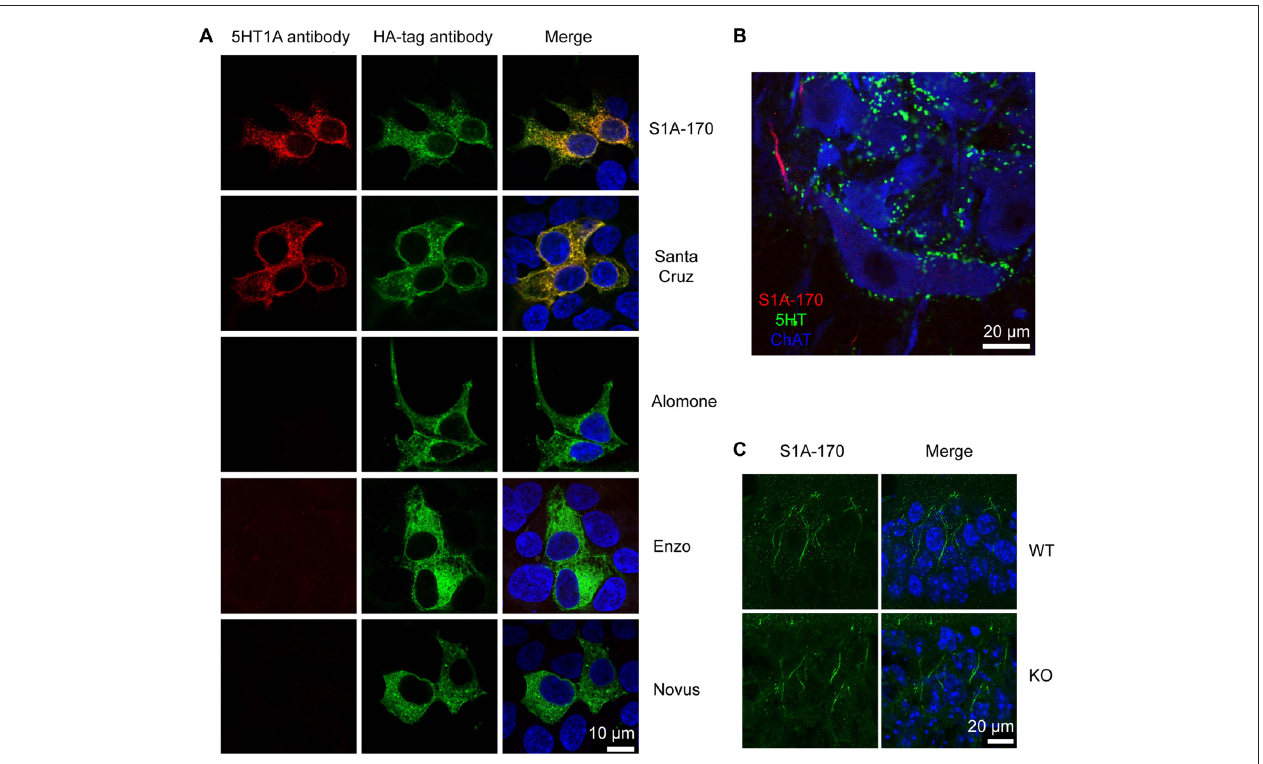
FIGURE 4 | Unspecificity of available 5HT 1A antibodies. (A) HEK293 cells transfected with HA-tagged h5-HT 1A and stained with anti-HA antibodies in combination with five different anti-5-HT 1A antibodies. Anti-5-HT 1A staining (red) obtained using the five antibodies is depicted in the left column, while anti-HA (green) is shown in the middle column. Only two antibodies were able to recognize HA-h5-HT 1A expressing HEK293 cells, S1A-170 and H-119 from Santa Cruz Biotechnology. The remainder of the antibodies revealed either no staining or unspecific staining. Staining of the nuclei with 4 (cid:48) ,6-diamidino-2-phenylindole (DAPI) is included in blue in the merged images to the right. (B) Turtle spinal cord section triple-labeled with S1A-170 (red), 5-HT (green) and choline acetyltransferase (ChAT, blue, marker of motorneurons). S1A-170 stained the proximal region on a motoneuron neurite consistent with the previously reported AIS staining with this antibody. (C) Mouse hippocampal CA1 wild-type and knockout tissue sections were stained with S1A-170 (green). As shown, stainings consistent with the localization of the AIS was observed in pyramidal cells of wild-type animals. The staining was, however, not eliminated in 5-HT 1A knockout animals demonstrating that this staining is not specific for 5-HT 1A . The right column represents overlay images of S1A-170 immunoreactivity and DAPI signal